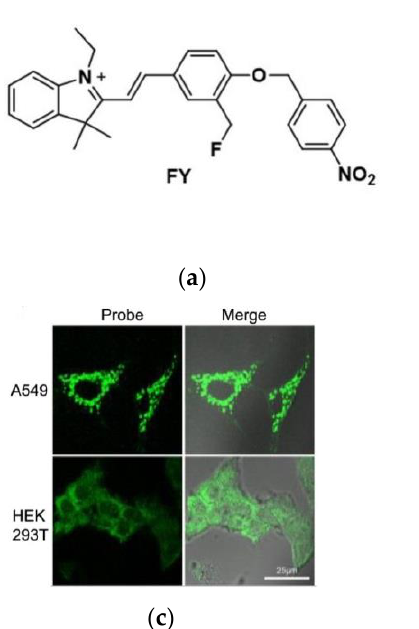
Figure 12. ( a ) Structure of probe FY; ( b ) Spectrogram of NTR and FY reaction in the presence of NADH; ( c ) Fluorescent images of A549 and HEK239T cells. Reproduced with permission from [64]. Copyright 2022 American Chemical Society.